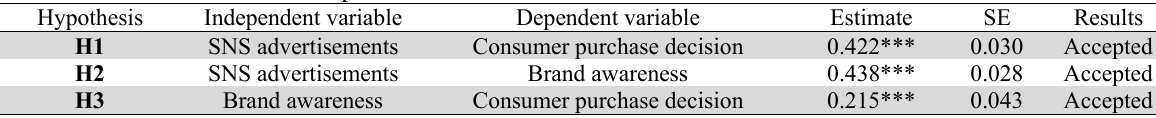
The results of direct effects of path results Hypothesis